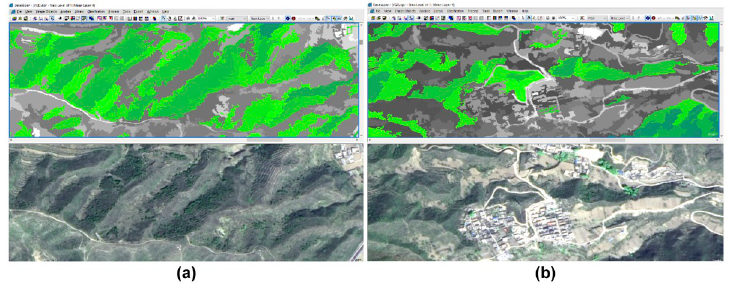
Fig 5. Effects of scenic resource identification after segmentation (using forest as an example). (a) Mountain and (b) residential areas (Republished from [https://directory.eoportal.org/web/eoportal/satellite-missions/g/gaofen-2] under a CC BY license, with permission from [Hebei Zhongke Sino Star Information Technology Co., Ltd], original copyright